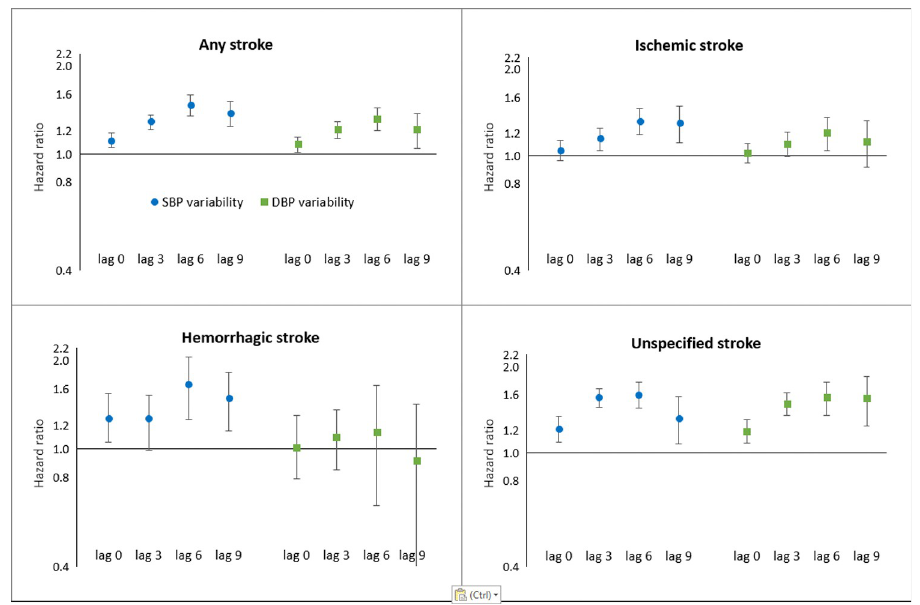
Fig 2. The association between blood pressure variability and incident stroke using different lag periods. The blue dots and green squares represent the hazard ratio of incident stroke per SD increase in systolic blood pressure (SBP) variability and diastolic blood pressure (DBP) variability, respectively. The error bars show the 95% confidence intervals around the estimates. The lag 0 models were adjusted for age, sex, mean SBP or DBP, education, BMI, smoking, alcohol consumption, cholesterol, high-density lipoprotein cholesterol, lipid-lowering medication use, blood-pressure-lowering medication use, anti-thrombotic medication use, type 2 diabetes mellitus, atrial fibrillation, prior coronary heart disease, and type of blood pressure measuring device. Lag 3, lag 6, and lag 9 analyses were adjusted for age, sex, mean SBP or DBP, and propensity score based on all other covariates. Lag 0 represents no time interval between blood pressure variability measurement and follow-up for incident stroke, lag 3 represents a time interval of 3 years between blood pressure variability measurement and follow-up for incident stroke, and so